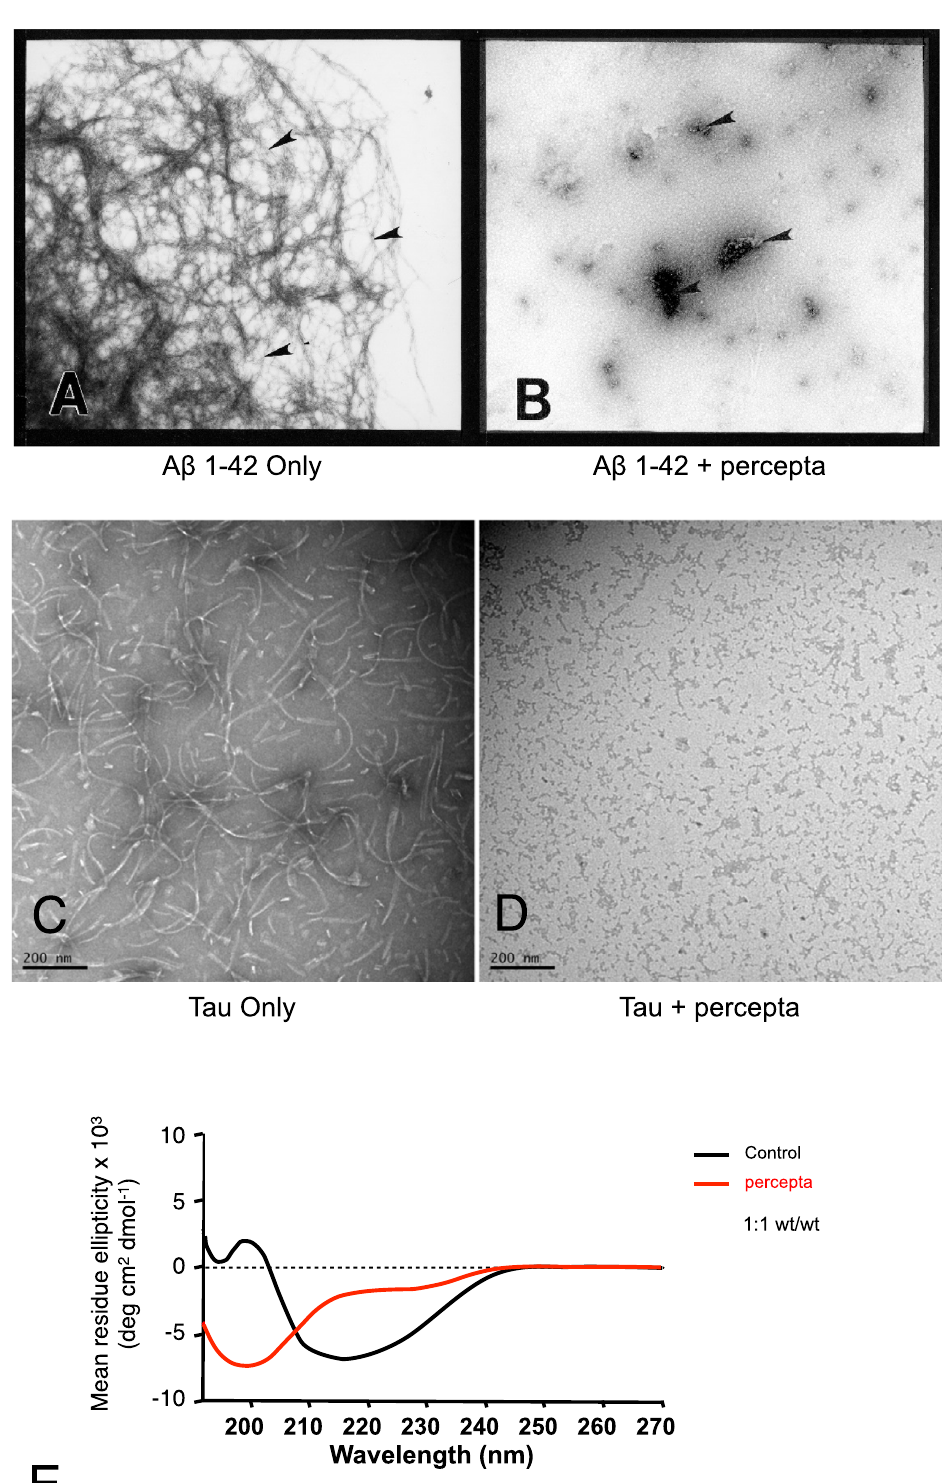
Figure 8. Disruption of Aβ 1–42 fibrils and tau protein tangles by percepta as shown by negative stain electron microscopy. ( A ) Aβ 1–42 fibrils (arrowheads) at 3 days as visualized by electron microscopy. × 30,000 magnification. ( B ) Aβ 1–42 fibrils in the presence of percepta following 3 days of co-incubation demonstrates only amorphous non-fibrillar material remaining (arrowheads). ( C ) Tau protein tangles formed by tau-441 induced in the presence of heparin for 3 days. Bar = 200 nm. ( D ) Marked dissolution/disaggregation of pre- formed tau protein tangles in the presence of percepta. Bar = 200 nm. ( E ) Percepta prevents formation of β-sheet tau protein tangles (shifts to α-helix) within 72 h as determined by CD